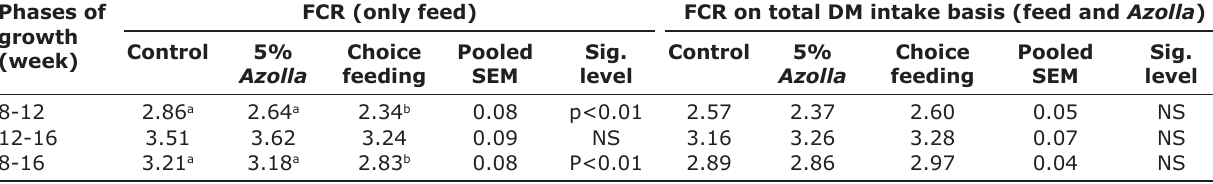
Table-3: Effect of Azolla feeding on the FCR (only feed) and FCR on total DM intake basis (feed and Azolla ) of grower turkey during 8-12, 12-16, and 8-16 weeks of age. Phases of